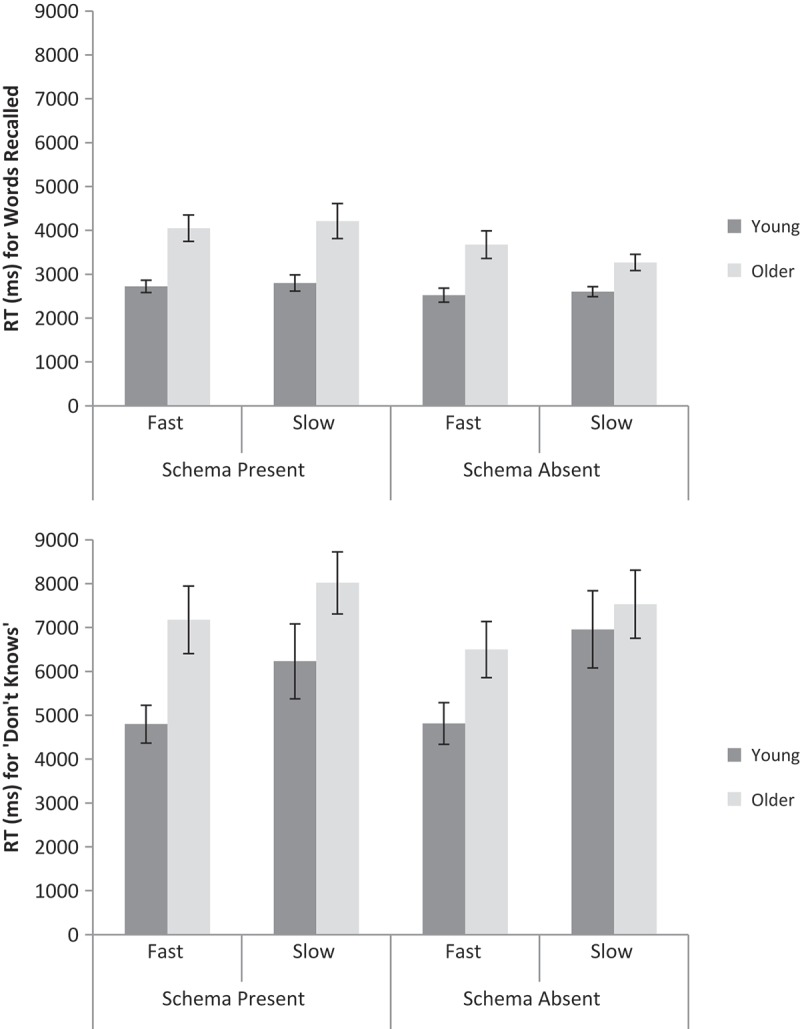
Mean RTs (based on medians for each participant) for correct (top panel) and “don’t know” (bottom panel) responses for schema-present and schema-absent conditions, fast and slow encoding speeds, and young and older adults in Experiment 1. Error bars are ±1 SE.